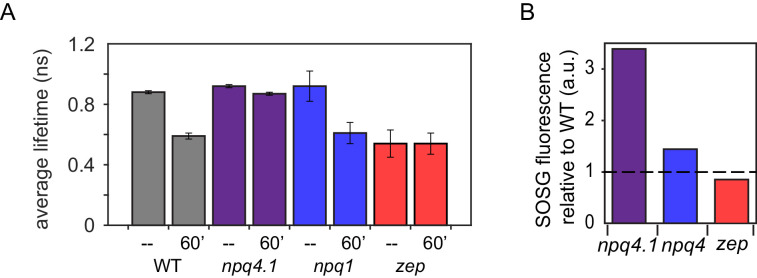
Fluorescence lifetime decay of Chlamydomonas reinhardtii whole cellsat 77K and singlet oxygen formation.(A) Fluorescence lifetimes were measured on high light (HL; 500 μmol m -2 s -1 ) acclimated samples. Each genotype was measured at a dark-adapted state (--) or after 60 min of HL treatment (1500 μmol m -2 s -1 , 60’). WT samples shown here are 4A + strain. Similar results were obtained in the case of CC4349 strain. The npq4 lhcsr1 mutant is indicated here as npq4.1. Fluorescence lifetime values for all genotypes and light conditions are shown in Figure 3—figure supplements 1 and 2. The fluorescence data are provided in Figure 3—source data 1 with fit values in Figure 3—source data 2. (B) Singlet Oxygen Sensor Green (SOSG) fluorescence emission measured for HL acclimated samples relative to WT (4A+ for npq1 and npq4 lhcsr1, CC4349 for zep). Dotted line represents WT level at 1. The results reported are representative of three independent biological replicates for each genotype in low light (LL) or HL. SOSG kinetics are shown in Figure 3—figure supplement 3. LL acclimated samples are shown in Figure 3—figure supplement 4. SOSG emission data is provided in Figure 3—figure supplement 5—source data 1.
Figure 3—source data 1.In vivo 77K fluorescence lifetime decays from TCSPC where individual sheets demarcate different genotypes acclimated to either low light (LL) or high light (HL) with the individual data from two independent biological and technical replicates after exposure to 60’ of HL or in the dark.For each measurement, the first column is the time (ns) and the second column is photon counts.

Figure 3—source data 2.77K time resolved fluorescence analysis and average fluorescence decay lifetimes of whole cells.Kinetics of Figure 3—source data 1 were fitted with a three-exponential decay function using Vinci two software from ISS. Fractions (fi) and time constants (τi) are reported. Average fluorescence lifetimes were calculated as Σfiτi. The results reported are two independent experiments with two independent biologic replicates.

Figure 3—source data 3.Time resolved fluorescence analysis and average fluorescence decay lifetimes of isolated monomeric (b2) and trimeric (b3) light-harvesting complexes.Kinetics of Figure 3—figure supplement 5—source data 1 were fitted with a two-exponential decay function using Vinci two software from ISS. Fractions (fi) and time constants (τi) are reported. Average fluorescence lifetimes were calculated as Σfiτi. Errors are reported as standard deviation (n = 2).

Figure 3—source data 4.In vivo SOSG fluorescence emission kinetics where individual sheets demarcate different genotypes acclimated to either low light (LL) or high light (HL).For each measurement, the first column is the time at which the fluorescence (arbitrary units) was measured. The following columns are the measured fluorescence of replicate experiments as well as the standard deviation for the specific sample.